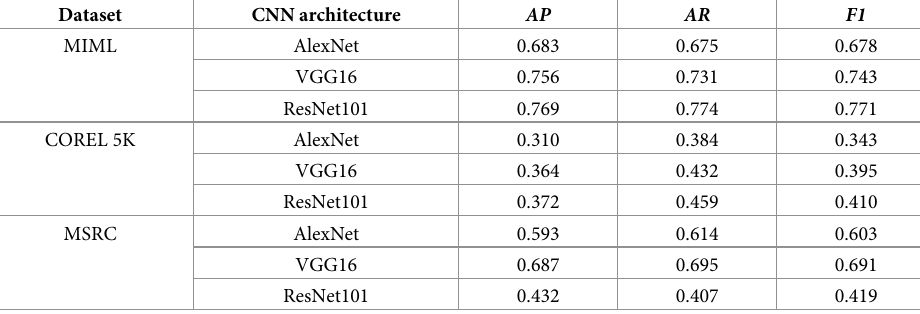
Table 3. Comparison among different CNN architectures.